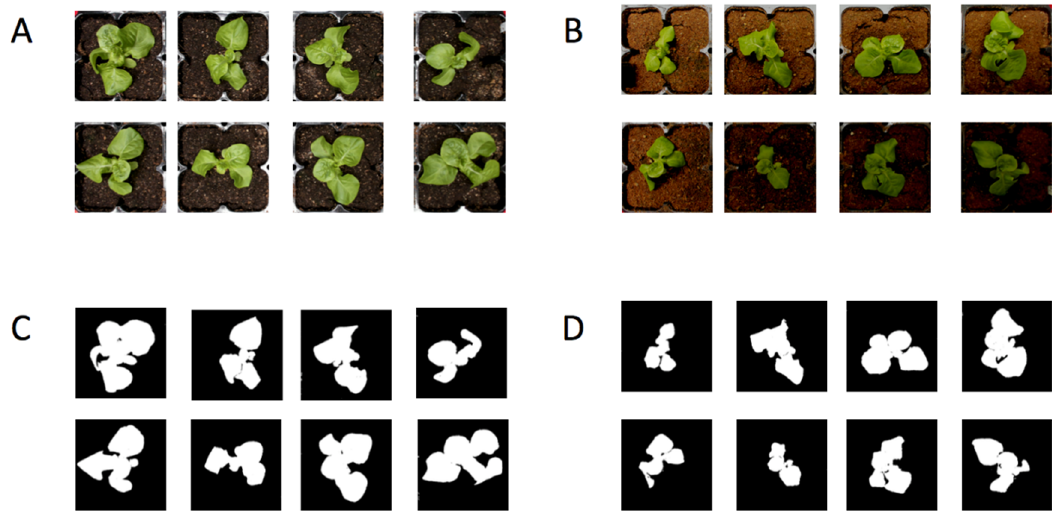
Figure 3. Visualized of cropped and processed images of green lettuce at 19 days after sowing (DAS). ( A ) Cropped individual lettuce images at 200 µmol ms –1 s –1 . ( B ) Cropped individual lettuce images at 400 µmol ms –1 s –1 . ( C ) Visualized image analysis result of lettuce at 200 µmol ms –1 s –1 . ( D ) Visualized image analysis result of lettuce at 200 µmol ms –1 s –1 .